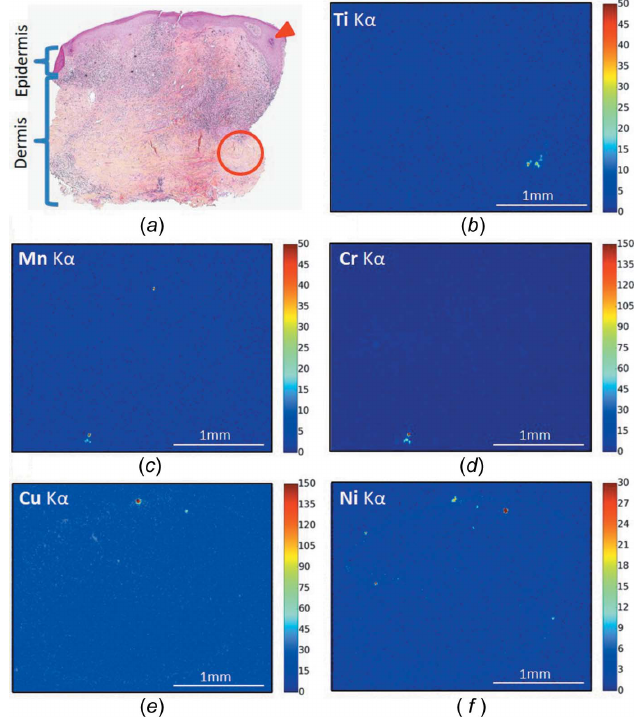
Table 1 Patient characteristics and ink composition (N.A., not available; PR, pigment red; PB, pigment blue). Patient Sex, age Color Skin eruption